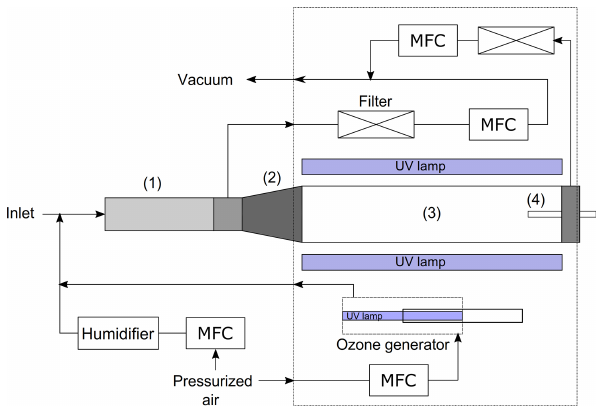
Figure 1. TSAR layout. The residence time chamber (1), the expan- sion tube (2), the oxidation reactor (3) and the adjustable outlet